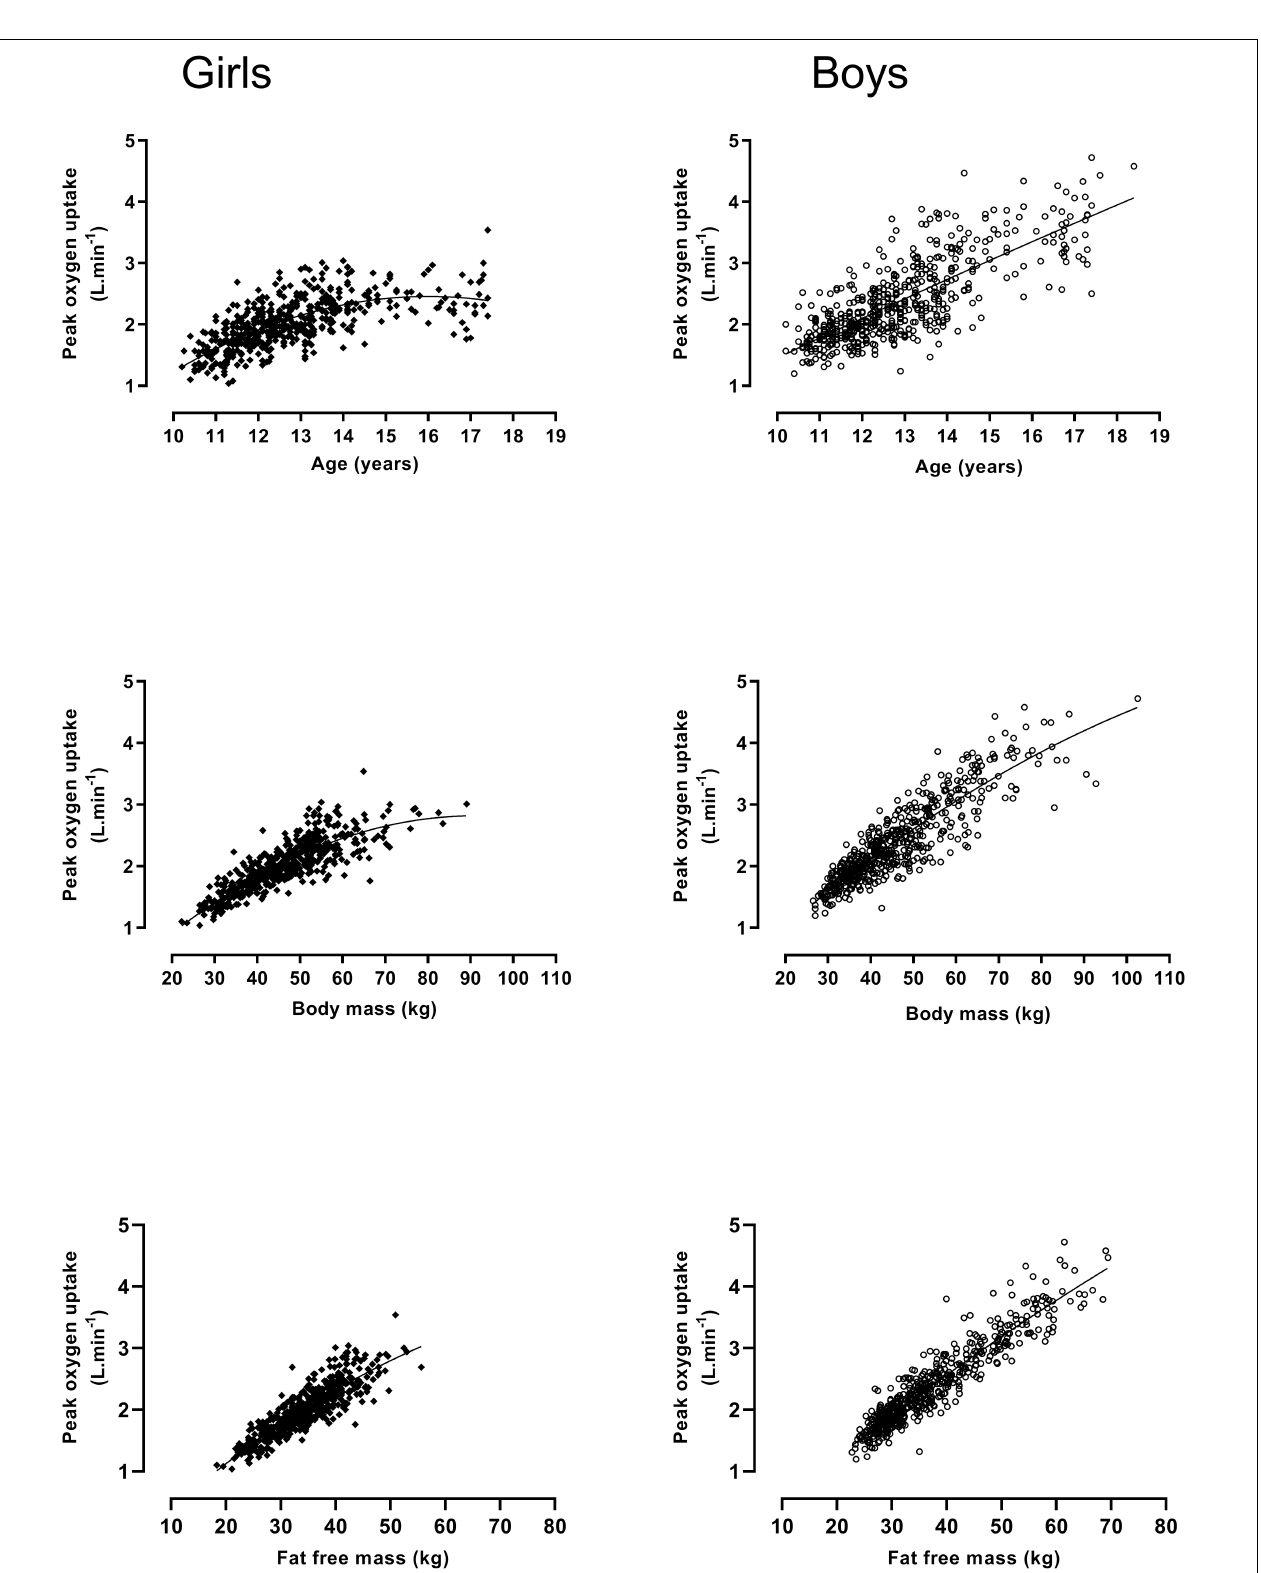
FIGURE 1 | Peak oxygen uptake by age, body mass, and fat free mass in 10–18-year-old girls and boys: Figure founded on 1057 determinations of peak oxygen uptake, age, body mass, and fat free mass; girls ( n = 501), boys ( n = 556). Data from Armstrong and Welsman (2019b).